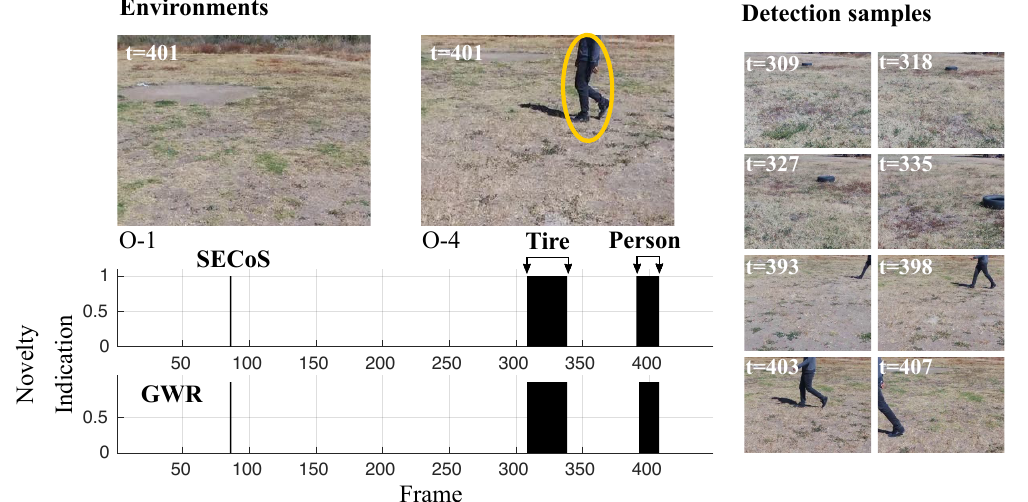
Figure 18. Visual results in novelty detection on dataset D-5, with the person and the tire as the novel